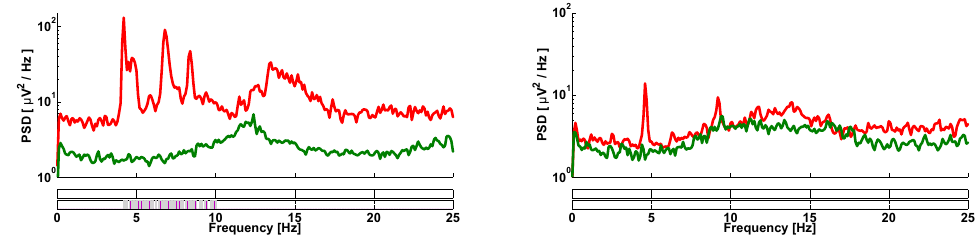
Figure 1. An example of the spectra of envelopes of EMG signals collected from PD patients and healthy volunteers. The spectra are computed using the standard Welch method. The Hann window was used, the window width was 10 s, and the window overlap was 7/8. The red curve indicates the PD patients. The green curve indicates the healthy volunteers. On the left, an average spectrum of the tremor right hands of twelve PD patients and an average spectrum of the right hands of ten healthy volunteers are demonstrated. On the right, an average spectrum of the non-tremor left hands of the PD patients and an average spectrum of the left hands of the healthy volunteers are demonstrated. The abscissa is the frequency. The ordinate is the power spectral density in the logarithmic scale. Two bars below the figure indicate the results of the Mann–Whitney statistical test. Statistically significant differences are indicated by the magenta color. The lower bar corresponds to the alpha level 0.05. The upper bar corresponds to the Bonferroni-corrected alpha level 0.0002. The significant differences are observed only in the tremor hands of the PD